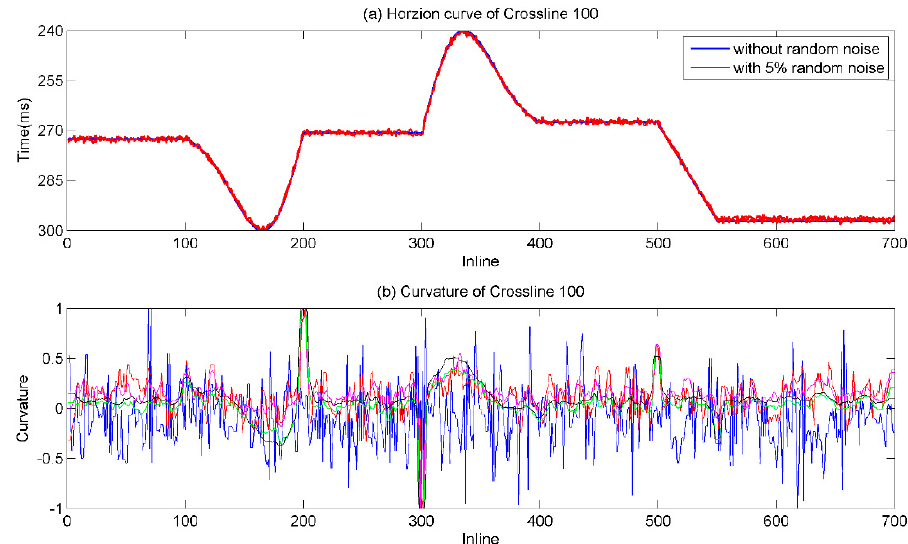
Figure 6. Horizon curve and mean curvature attribute with 5% noise: ( a ) Horizon curve and ( b ) mean curvature attribute of different time windows with 5% noise. Table 3. Correlation coefficient for different time windows with 5% noise.